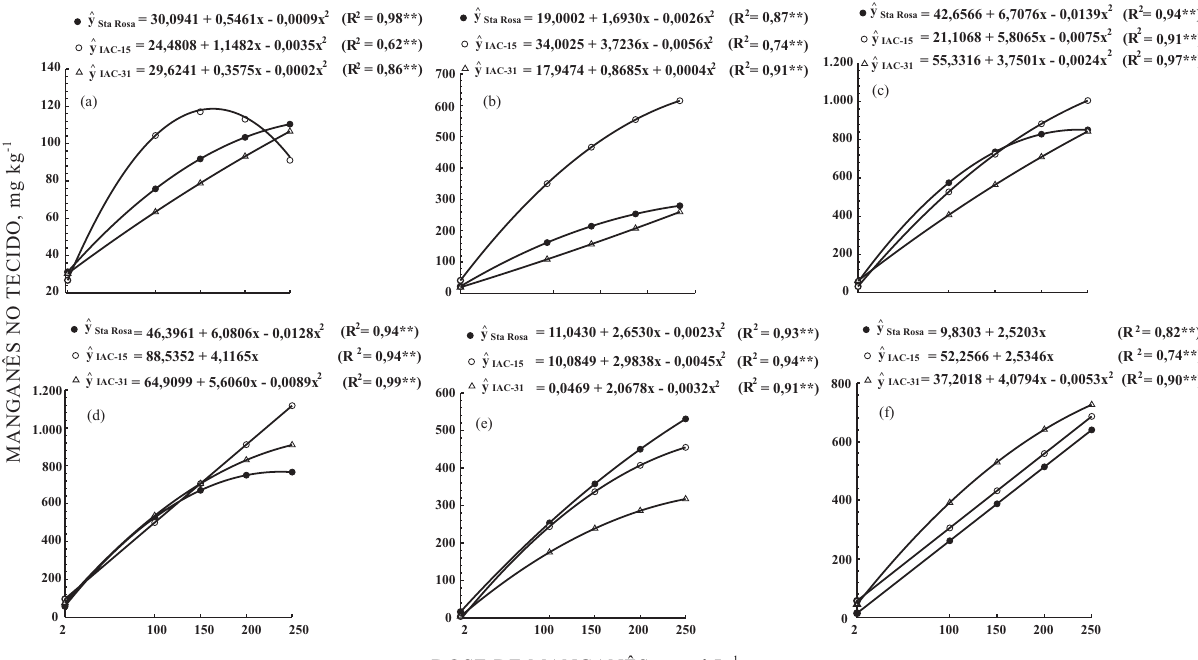
DOSE DE MANGANÊS, mol L (cid:2) Figura 2. Concentração de Mn nos grãos (a), nos pericarpos (b), nas folhas superiores (c), nas folhas inferiores (d), nos caules (e) e nas raízes (f) dos cultivares Santa Rosa ( ), IAC-15 ( ) e IAC-Foscarin 31 ( ΔΔΔΔΔ ), considerando as doses de 2, 100, 150, 200 e 250 μ mol L -1 de Mn, em solução nutritiva.